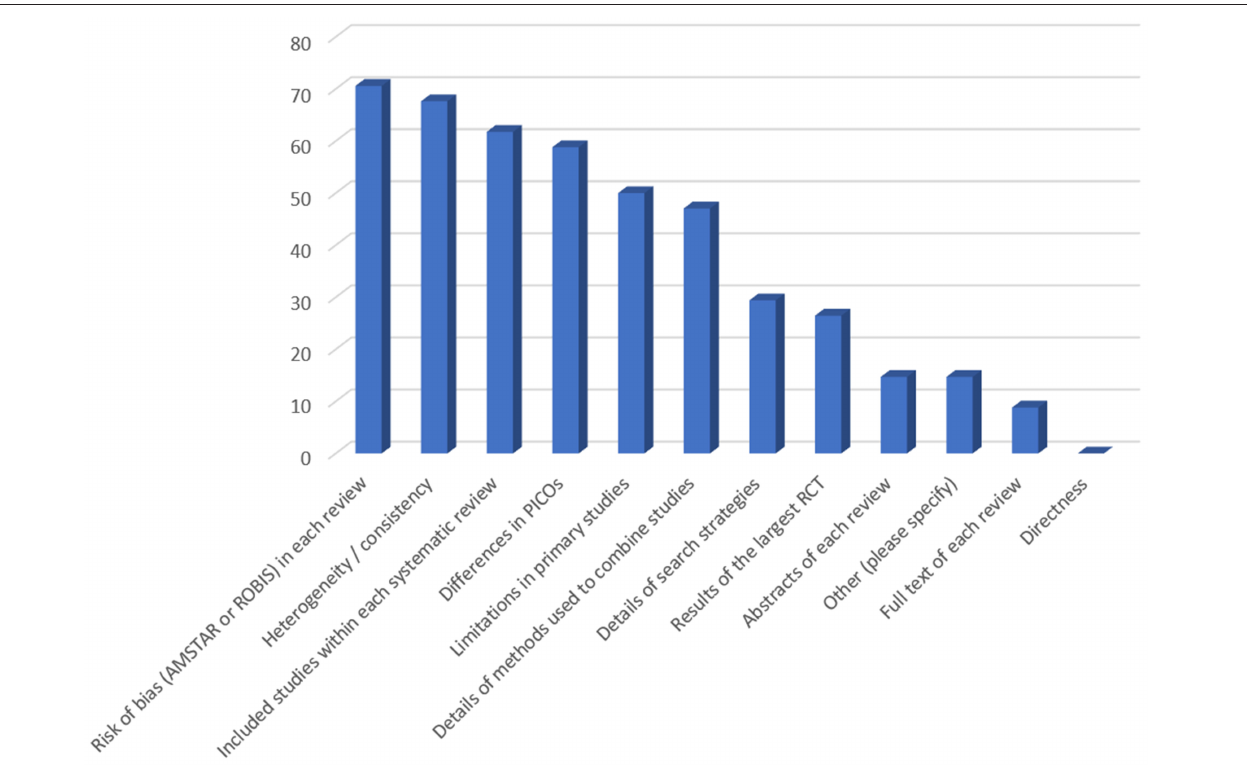
FIGURE 2 | Suggestions of participants regarding information needed for decision-making in case of overlapping systematic reviews (responses provided by 34 participants). Figure shows responses to the following question: In case of overlapping meta-analyses, on top of summary of findings table, which additional information would you like to have? (multiple answers allowed). Y-axis denotes percentage of participants.